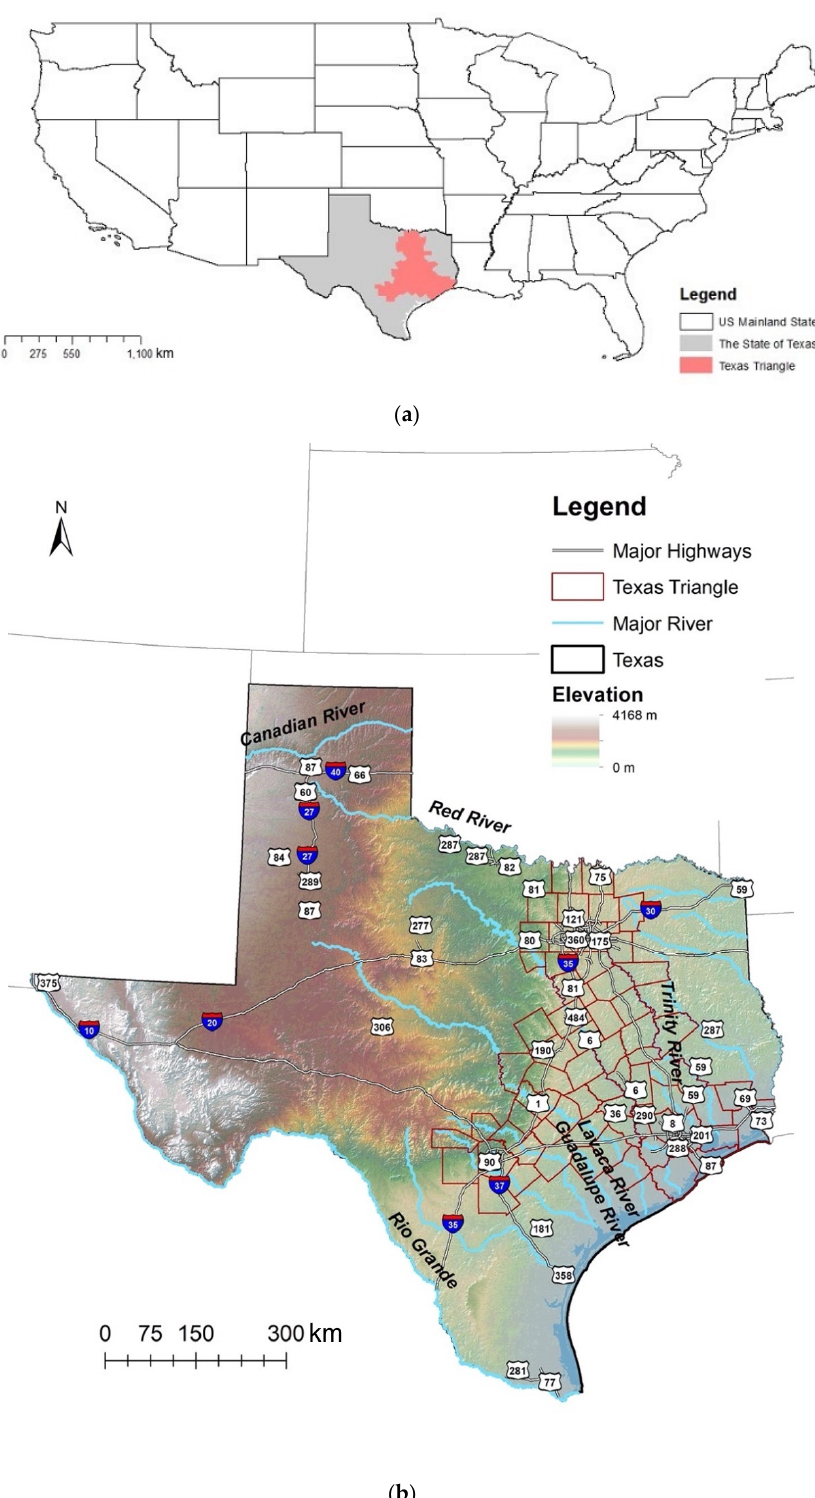
Figure 1. The Texas Triangle. ( a ): The location of the Texas Triangle in the U.S.; ( b ) the location of the Texas Triangle in the State of Texas. The elevation information is from the Texas Water Department Broad